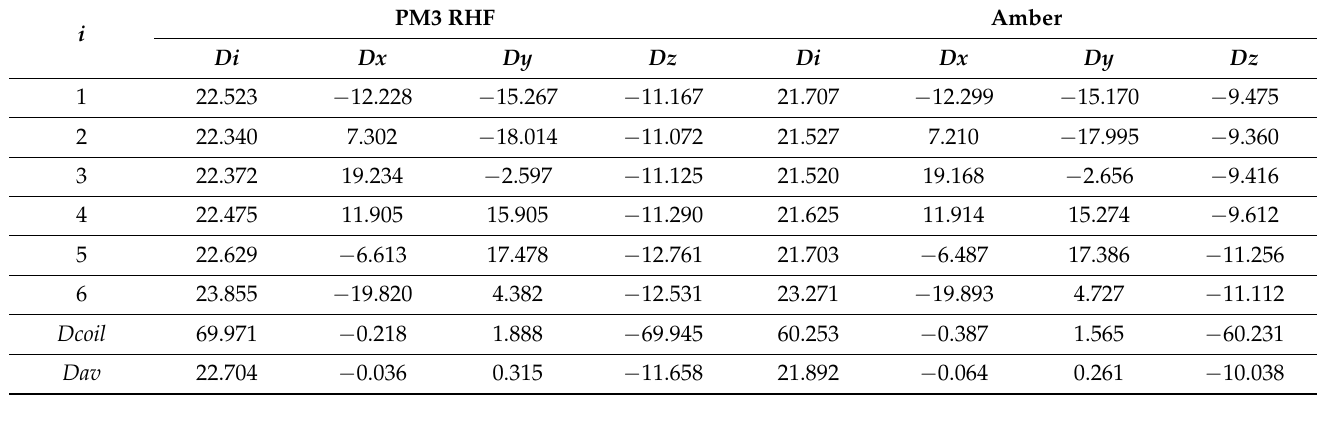
Table 4. Values of dipole moments for a coil of the helix-like D-FF PNT computed using PM3 (RHF) and Amber (after PM3) methods. All values of dipole moments are given in Debye units.